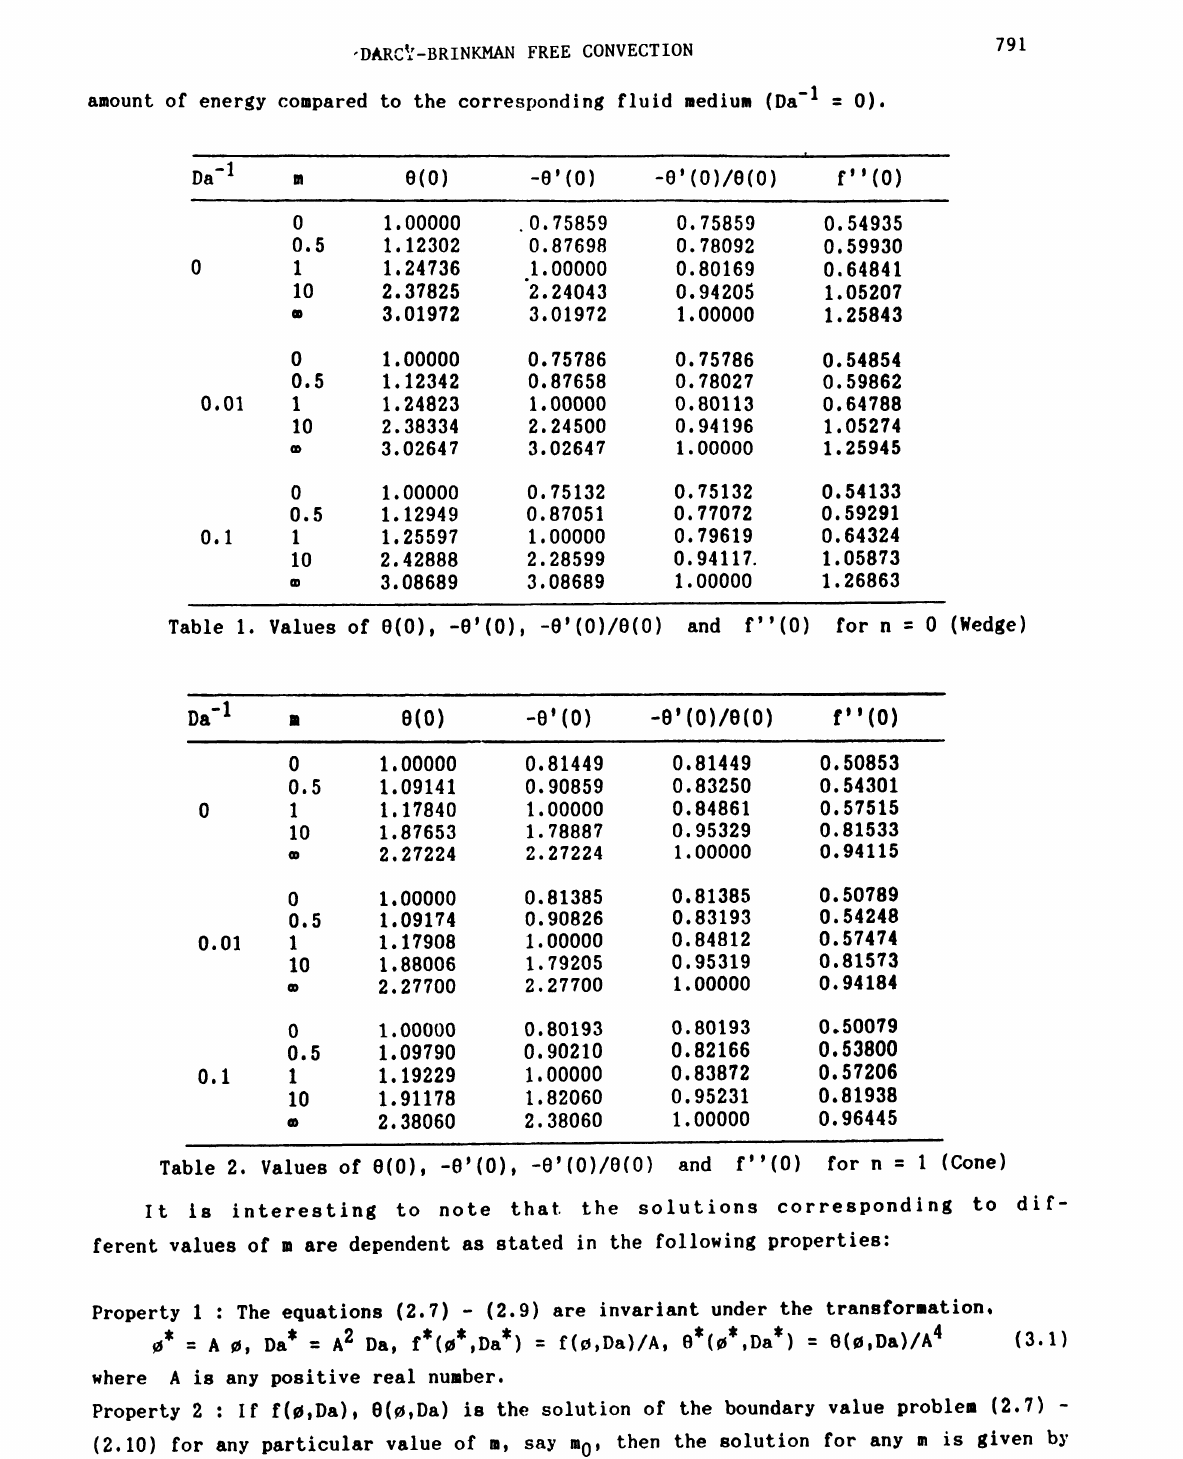
Table I. Values of O(0), -e’(0), -e’(0)/o(0) and f"(0)